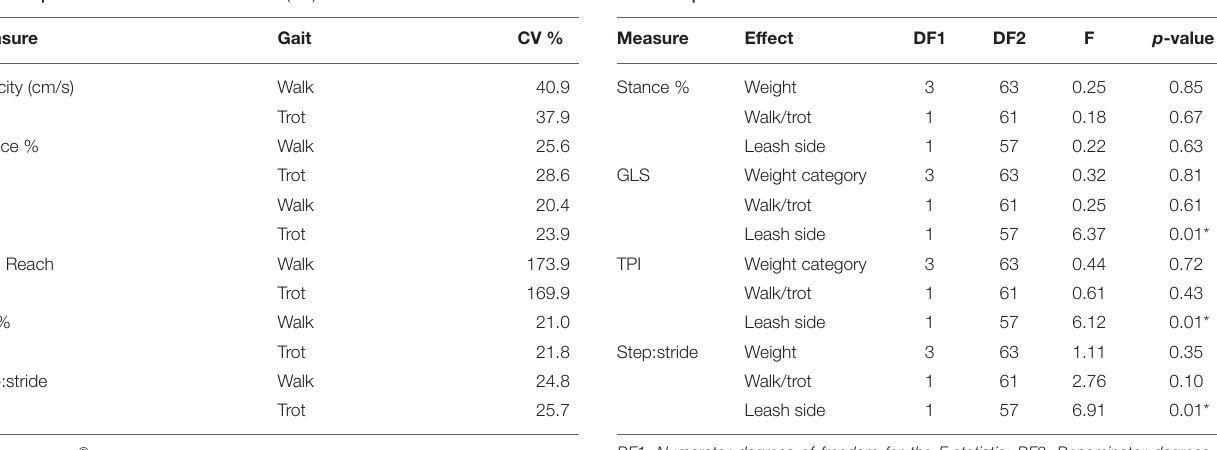
TABLE 3 | Overall Coefficients of Variation (CV) at walk and trot. TABLE 4 | Results of the mixed